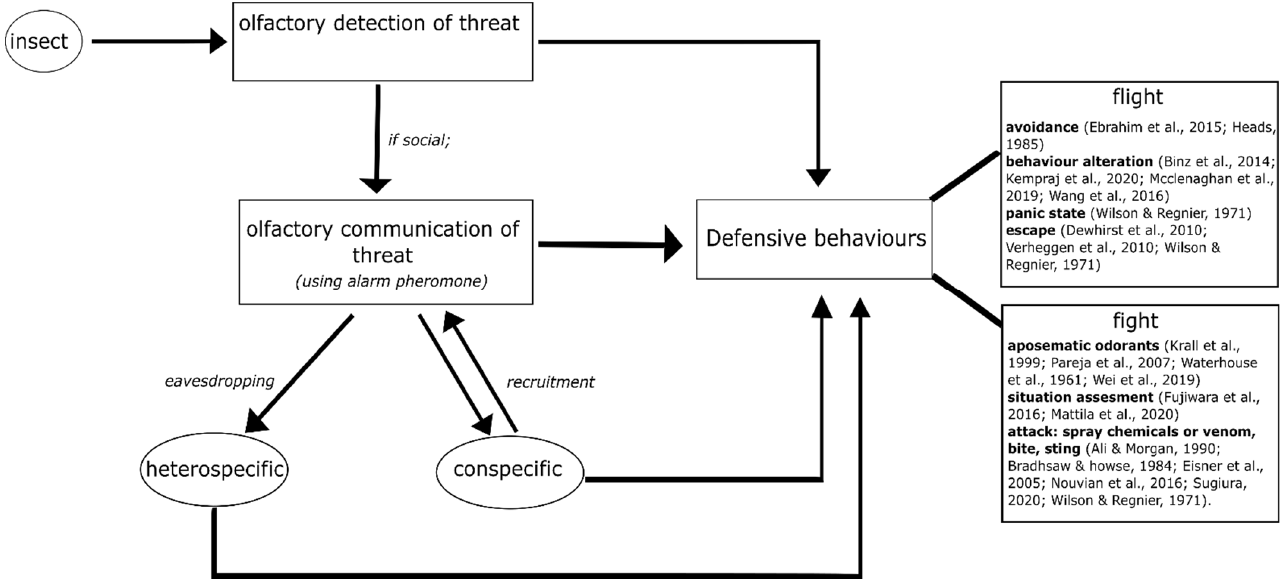
Figure 1. Olfactory strategies of insects in defensive behaviour: individual insects have a first strategy of olfactorily detecting their threat or disturbance and then eliciting a defensive behaviour. However, if they are members of a group and are social, the insects communicate the threat to their conspecifics by means of olfactory signals called ‘alarm pheromones’. Conspecifics respond to the alarm pheromone by eliciting a defensive behaviour and also by recruiting more conspecifics to perform the defensive behaviour. Sometimes, the alarm pheromone also acts as a signal to other species that share the same environment, i.e., heterospecific, leading them to a defensive behaviour against their common threat. Here, we show that defensive behaviour can mainly be classified into ‘flight’ or ‘fight’. ‘Flight’ includes avoidance of the predator/intruder, laying low-key to not attract attention, exhibiting a panic response by moving rapidly in circles or a zig-zag fashion, and escape. ‘Fight’ includes the use of aposematic or deterring odorants (along with a bitter taste) when attacked, masking with foul external odours to deter the intruder, and attacking–which ranges from biting, stinging, and spraying chemicals or venom. We have included key references next to the specific defensive behaviours, which are mentioned in detail in the main text and can be used for further reading.